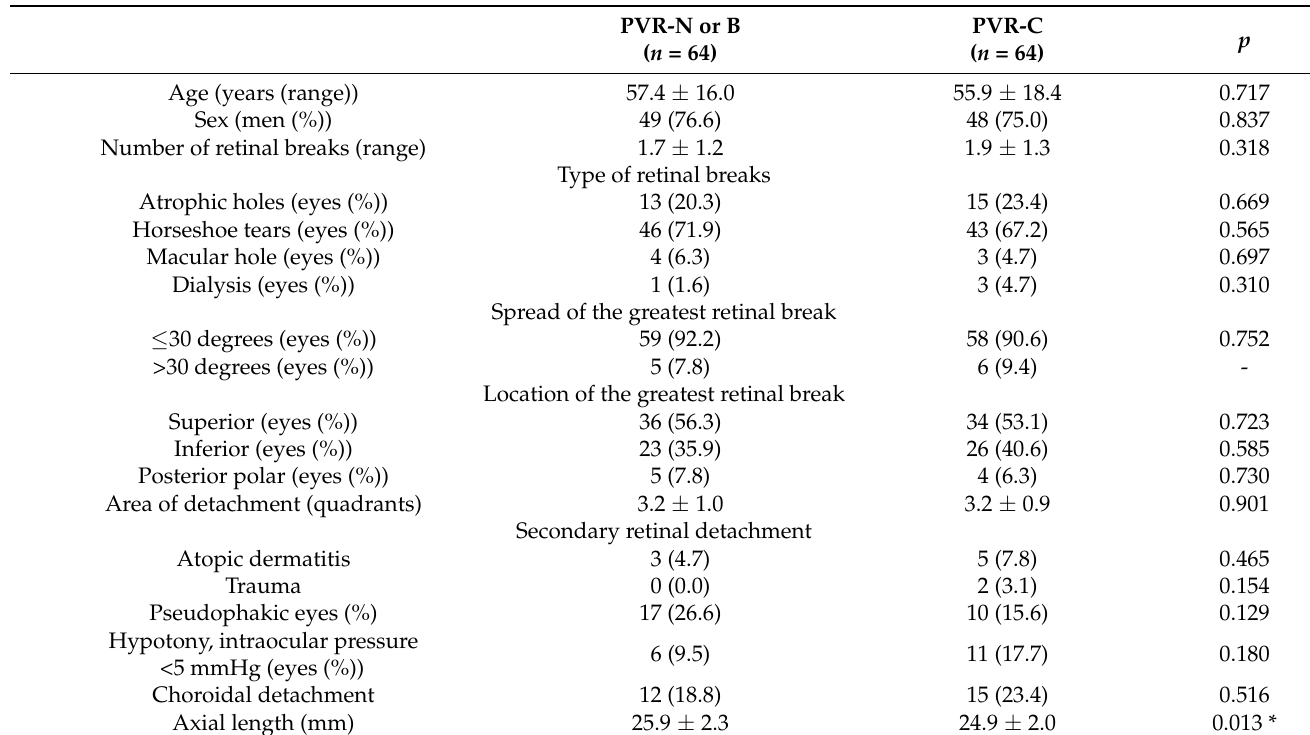
Table 3. Characteristics of the patients exhibiting proliferative vitreoretinopathy grade N or B, or proliferative vitreo- retinopathy grade C at baseline in the propensity-score matched